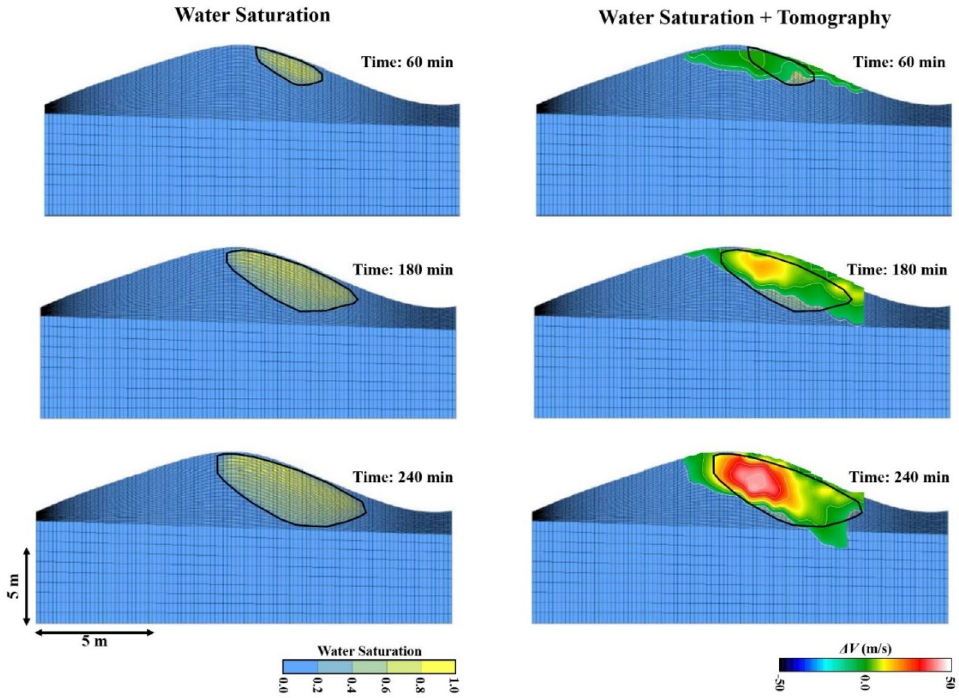
Figure 6. Fluid-flow simulation results showing (left) water saturation and (right) water-saturation + tomogram maps at different times. The images on the right are the P-velocity tomogram images overlain on the black boundary lines of the water-saturation images in the left column. Surfer 11 (https:// www. golde nsoft ware. com/ produ cts/ surfer) is used to plot this